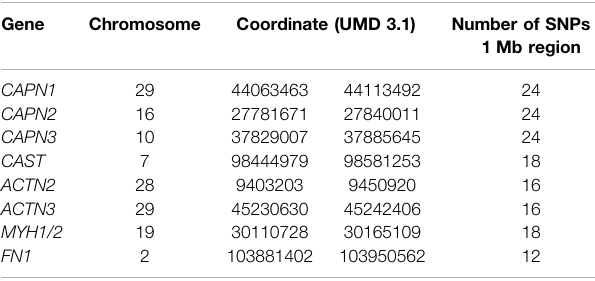
TABLE 6 | SNP haplotype block location